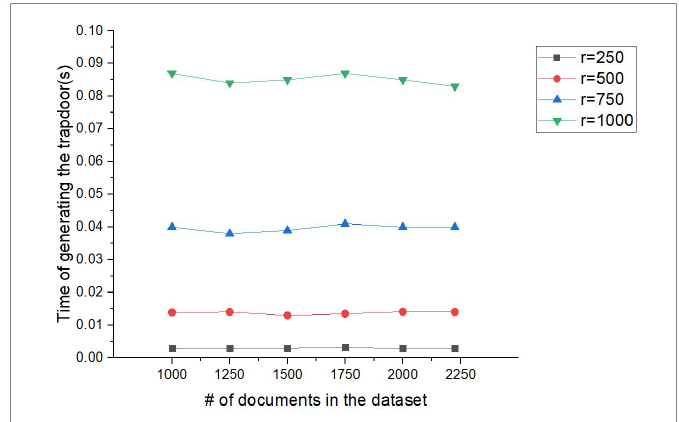
Figure 7. Time for generating the trapdoor.